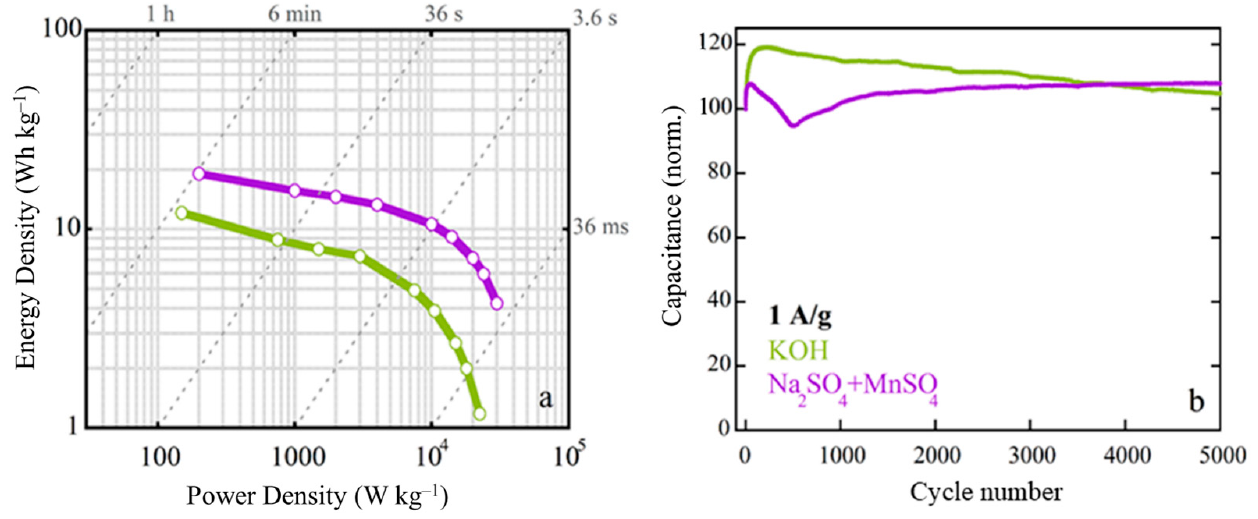
Figure 10. ( a ) Ragone plot of the final systems in the two electrolytes and ( b ) capacitance values for 5000 charge/discharge cycles at 1 A g − 1 .